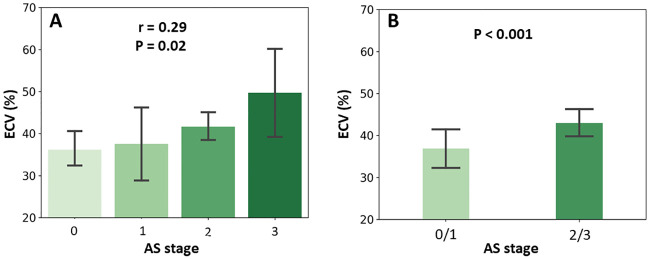
The relation between ECV fraction and staging classification of AS, based on the extent of cardiac damage.(A) In a Pearson correlation model, extracellular volume (ECV) fraction correlated significantly and progressively with aortic stenosis (AS) stage. To note, eight patients were at stage 0, nine patients at stage 1, 41 patients at stage 2, eight patients at stage 3, and none at stage 4. (B) In a logistic regression model, patients in stages 2 or 3 had a significantly higher ECV fraction compared to patients at stages 0 or 1.